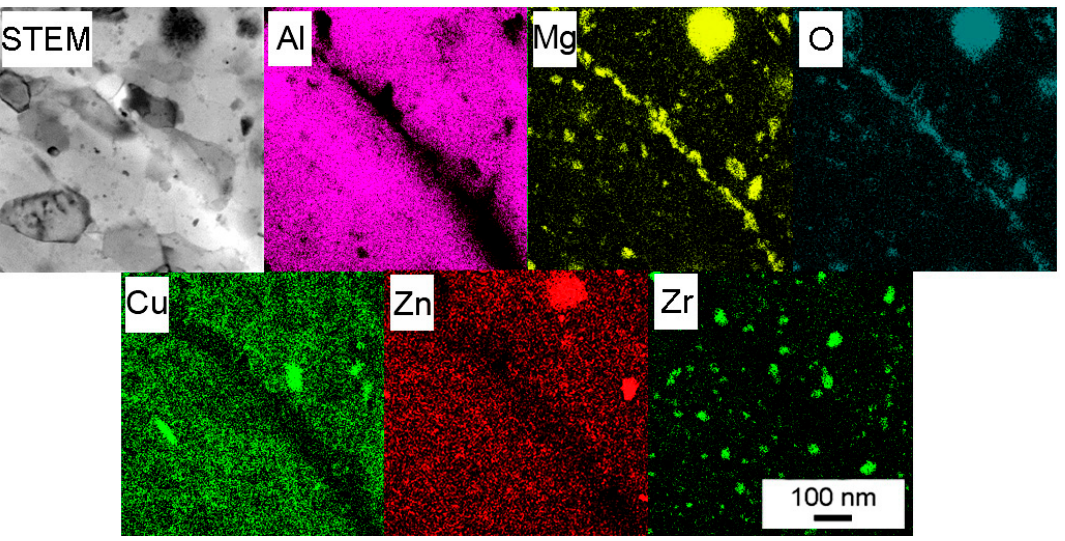
Figure 18. STEM image of the MgO layer observed in the Al7075Zr_MC compact and the corresponding EDS maps.